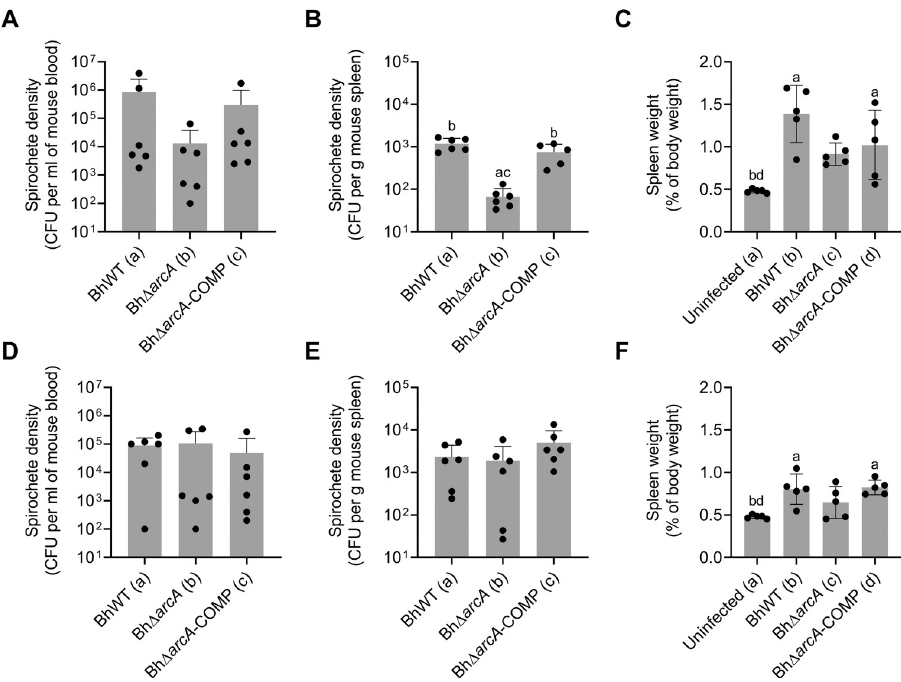
Fig 9. Arginine deiminase contributes to the survival of B . hermsii in the spleens of infected mice. Mice were inoculated with BhWT, Bh Δ arcA , or Bh Δ arcA -COMP by IP injection and cohorts were euthanized at day 5 (A-C; n = 6) and day 15 (D-F; n = 5). Mouse blood (A and D) and spleens (B and E) were plated to determine the number of spirochetes. Prior to euthanasia, mice were weighed, and spleens were excised and immediately weighed (C and F). Letters indicate P-value < 0.05 in a one-way ANOVA Tukey’s multiple comparison test.